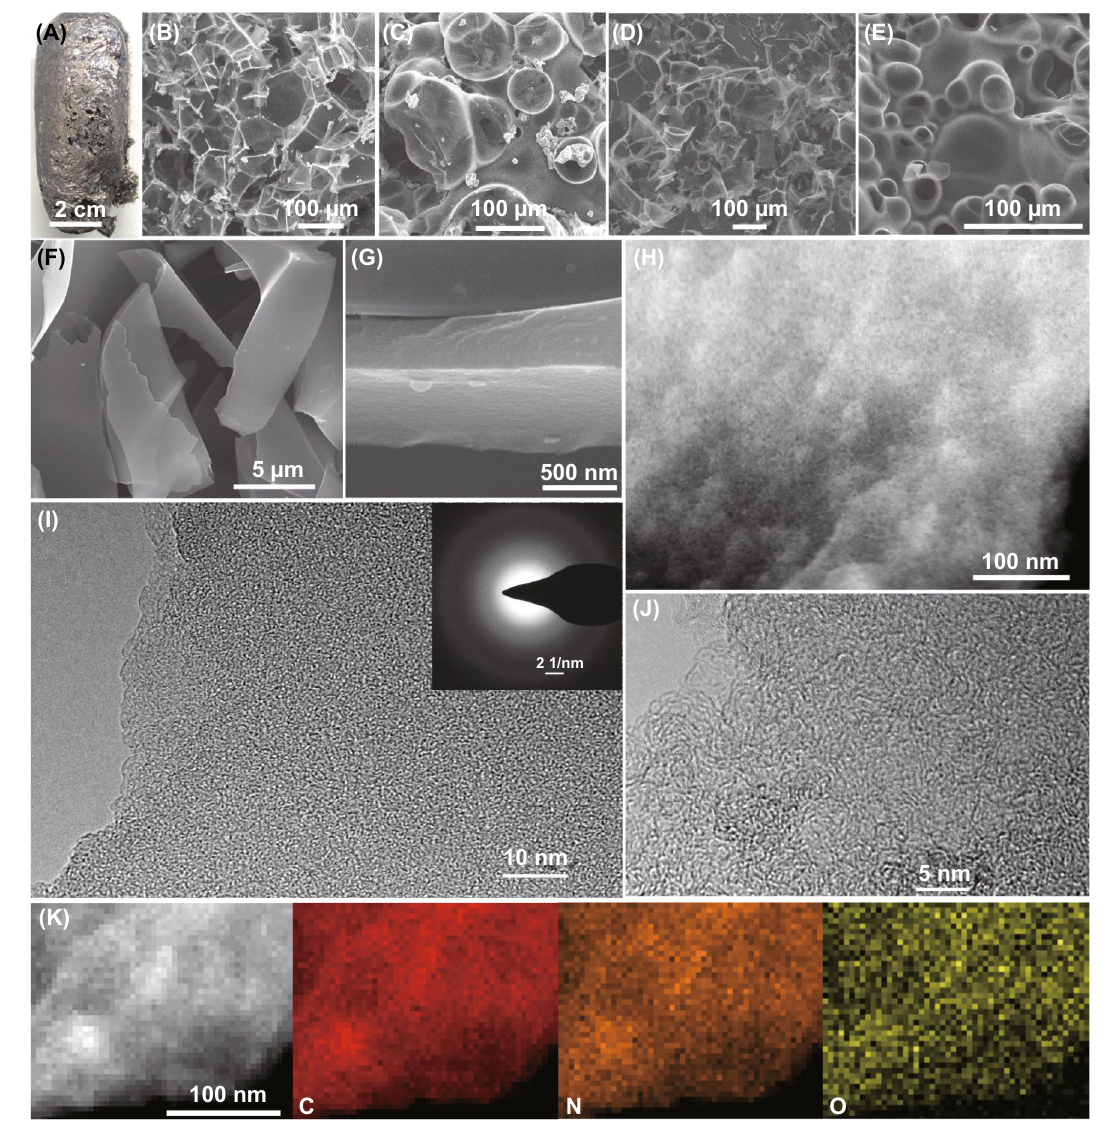
Fig. 2 A Optical, B – G SEM, H DF-STEM, I TEM, inset I SAED pattern, J HRTEM, and K elemental maps of the HPNCF-2.0-900 sample before ( A – C ) and after ( D – K ) water